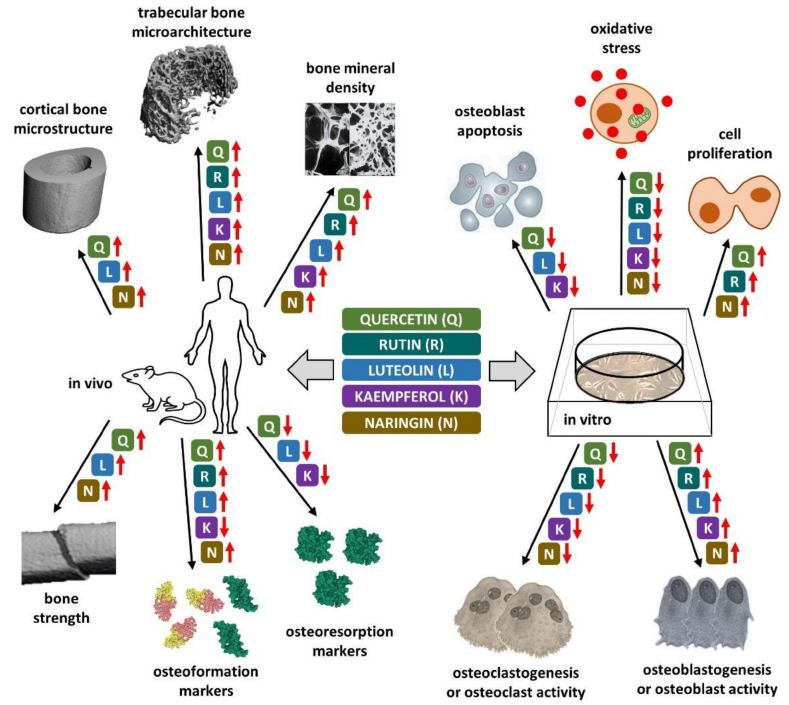
Figure 3. Effects of described flavonoid polyphenols on bone microstructural and biochemical parameters in vivo (left) and on bone cell parameters in vitro (right). The increase and decrease in a given parameter is indicated by red arrows pointing up and down, respectively. Q, quercetin; R, rutin; L, luteolin; K, kaempferol; N,